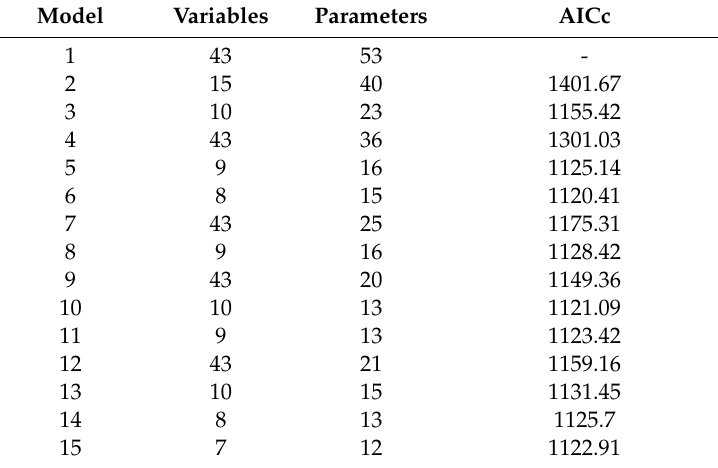
Table 1. Calculation values of Akaike information criteria (AICc) in each